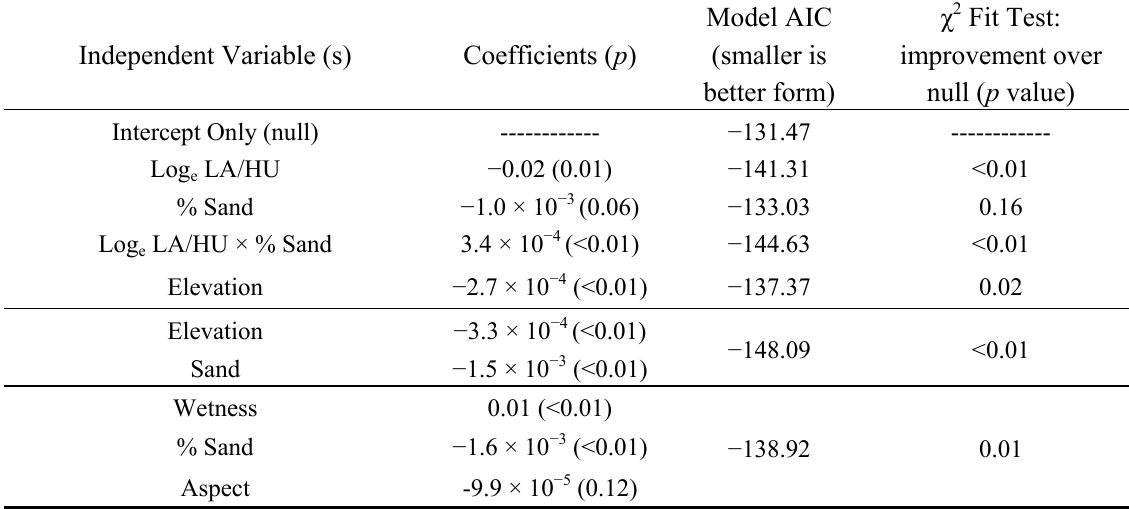
Table 3. Relationship between mean soil %N and housing density; linear mixed model on soil %